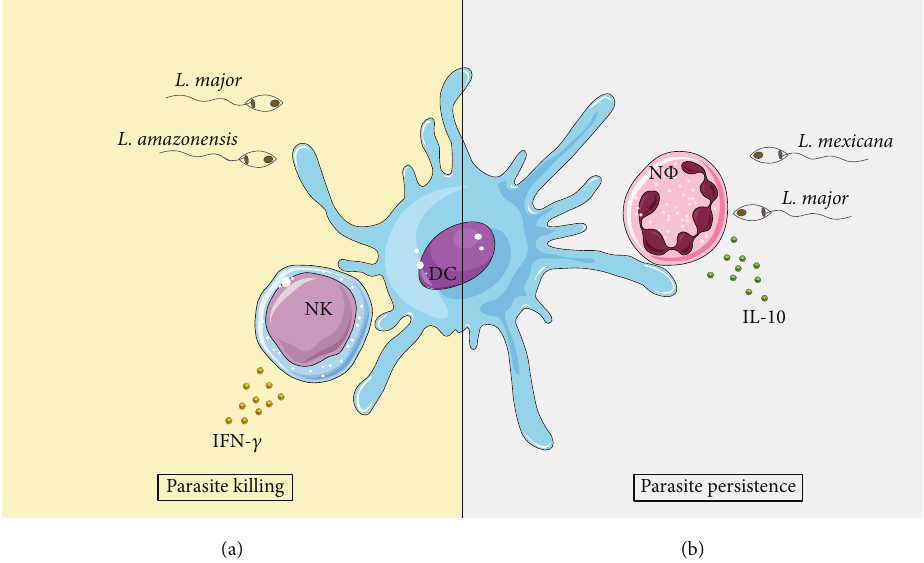
Figure 1: Interaction of DC with different leukocytes in the cutaneous leishmaniasis context. (a) shows the interaction among NK and infected DCs that leads to host immune protection and parasite killing through IFN- 𝛾 production during L. amazonensis [73] or L. major [74] infection. (b) shows the outcome induced by the increased production of IL-10 after the interaction between infected neutrophils (N Φ ) with L. major [75] or L. mexicana [76] and DCs, leading to parasite persistence.